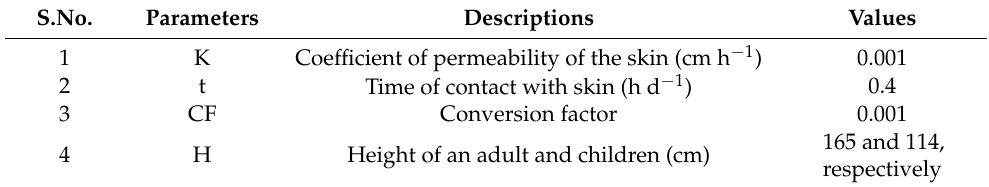
Table 5. Input values for different parameters used in the estimation of DA and